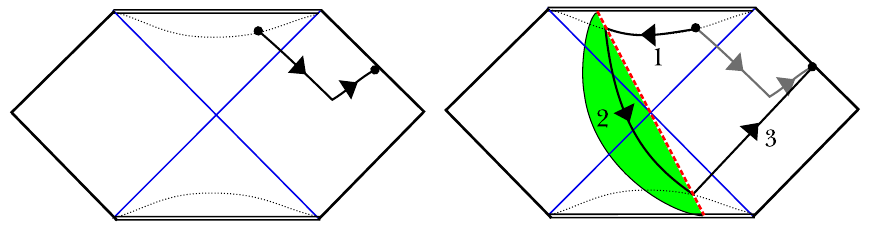
Fig. 5 Summarization of the Hartle–Hawking picture. Left: particle tunneling from inside to outside. Right: an equivalent path according to Hartle and Hawking. Path (1) is along the constant r surface, that does not contribute to the propagator, due to the time-translational invari-